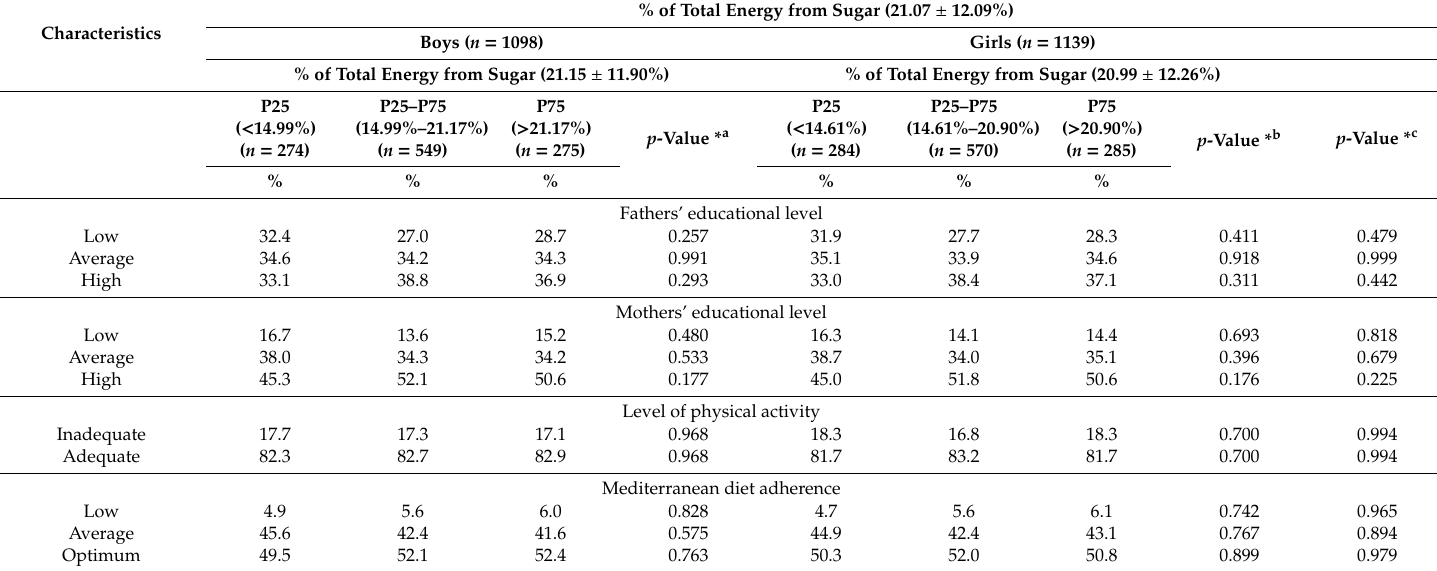
Table 4. Sociodemographic characteristics of schoolchildren in relation to % of total energy intake from sugar intake consumed by 6–8 years old children ( n = 2237) in Valencia, Spain,